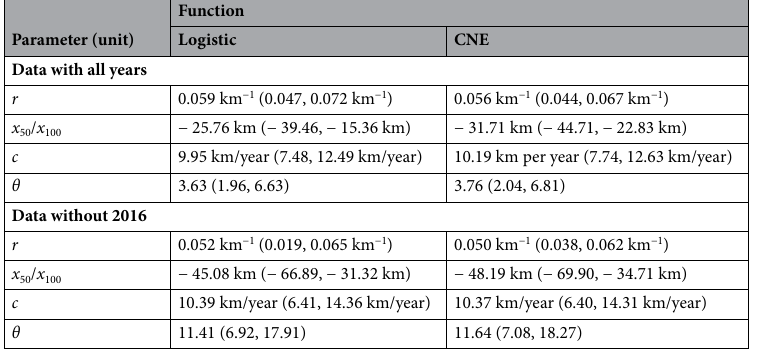
Table 3. Parameter estimates of the logistic and constrained negative exponential functions when fitted to data for all years, and assuming a constant rate of movement. Values in brackets are the 95% confidence limits. The values between the brackets are the lower and upper 95% confidence limits. CNE constrained negative exponential.